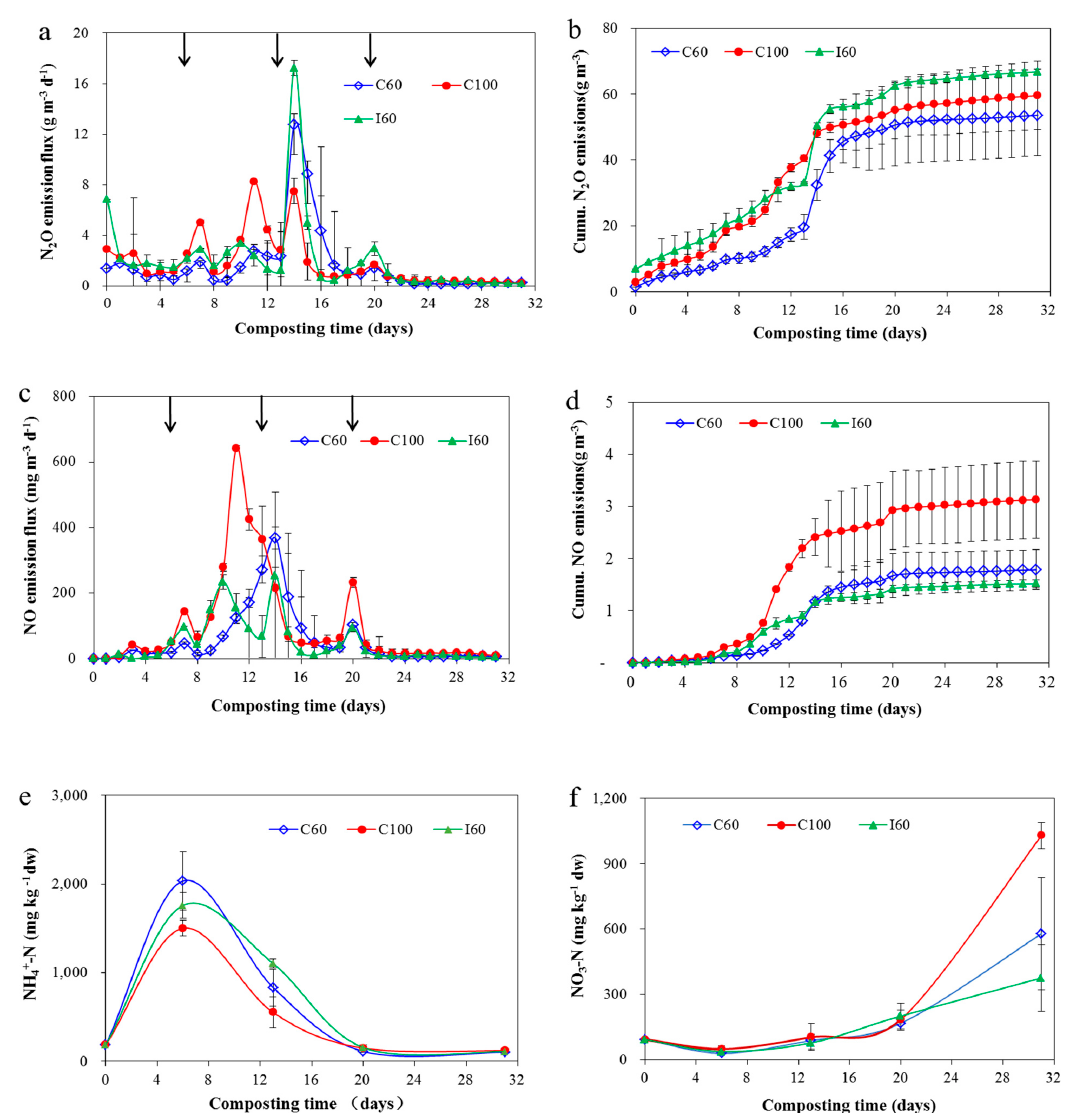
Figure 5. Change of N 2 O ( a ), cumulative N 2 O ( b ), change of NO ( c ), cumulative NO ( d ), emissions, change of NH 4 + -N ( e ) and change of NO 3 -N ( f ) during composting. Results are the mean of three replicates and error bars indicate standard deviation. Arrows indicate the time of turning. For abbreviations see Figure 1.